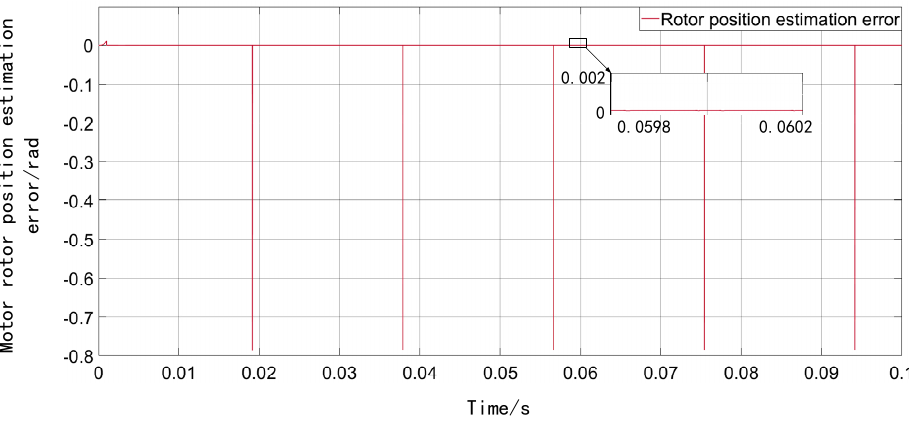
Figure 16. Variation curve of the rotor position estimation error of the new improved SMO at low